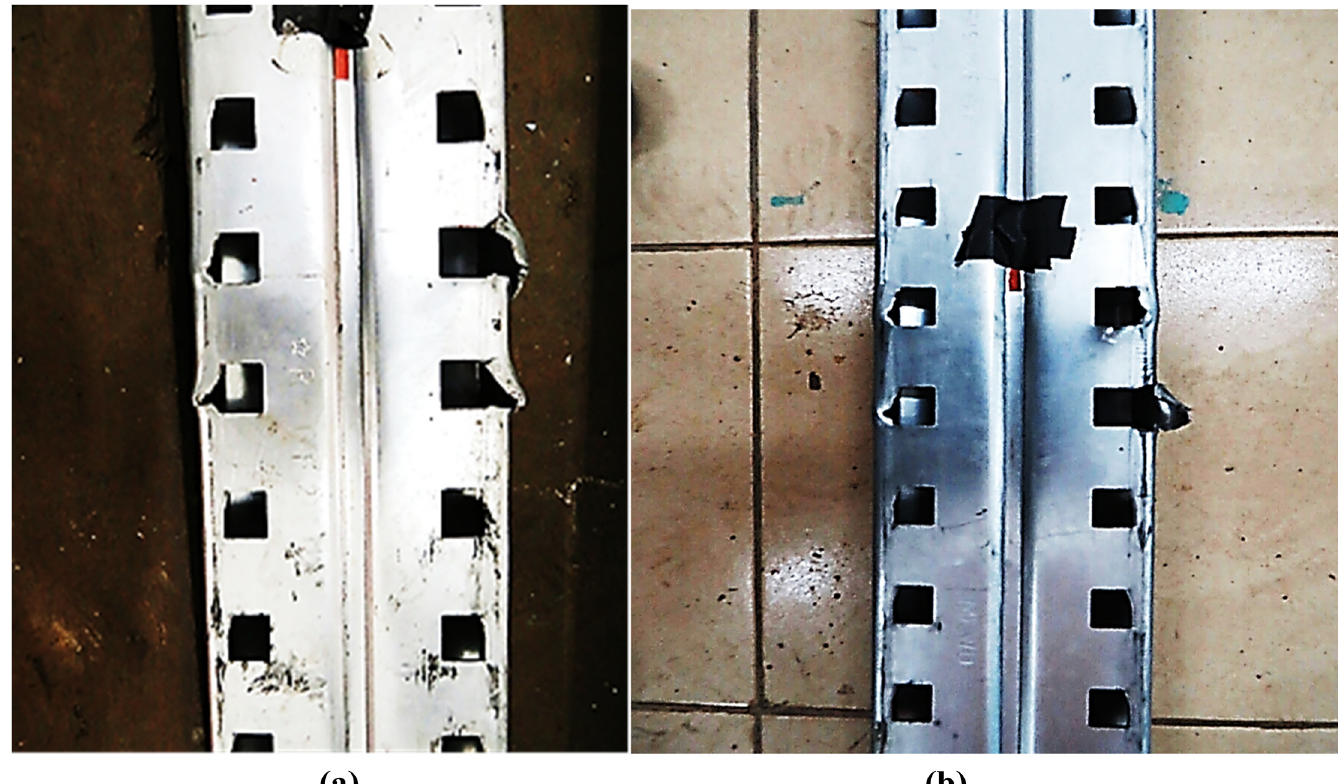
Fig 7. Deformation of columns. (a) Column A, (b) Column B.